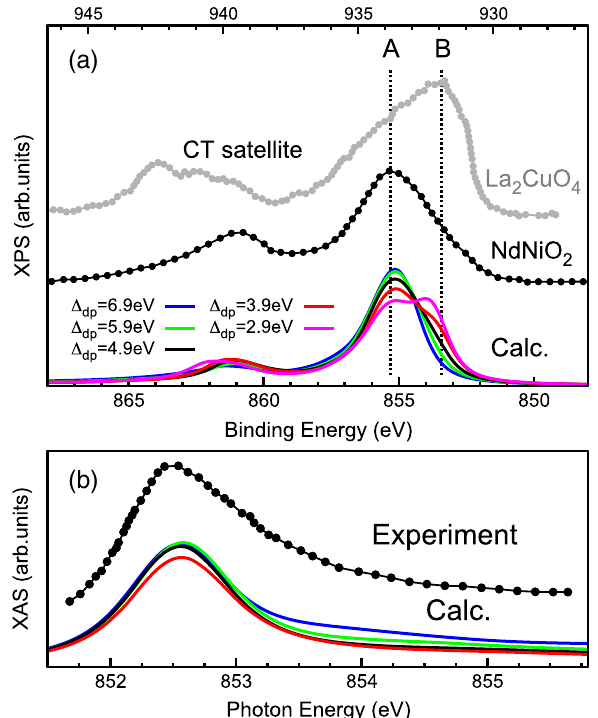
FIG. 5. (a) Ni 2 p 3 XPS spectra and (b) Ni 2 p 3 XAS spectra = 2 = 2 of NdNiO 2 calculated by the LDA þ DMFT method for different Δ values. The experimental data [9,12] are shown together. For dp FIG. 6. (a) Ni 2 p 3 XPS spectra and (b) Ni 2 p 3 XAS spectra comparison, experimental Cu 2 p 3 XPS data of La 2 CuO 4 are = 2 = 2 = 2 of LaNiO 2 calculated by the LDA þ DMFT method for different shown (gray) [19]. The spectral broadening is taken into account Δ values. The spectral broadening is taken into account using a using a Lorentzian 300 meV (HWHM) and a Gaussian 250 meV dp Lorentzian 300 meV (HWHM) and a Gaussian 250 meV (HWHM) for XAS and a Lorentzian 500 meV and a Gaussian (HWHM) for XAS and a Lorentzian 500 meV and a Gaussian 400 meV for XPS. The XPS spectra with different broadening 400 meV for widths can be found in Supplemental Material [54].